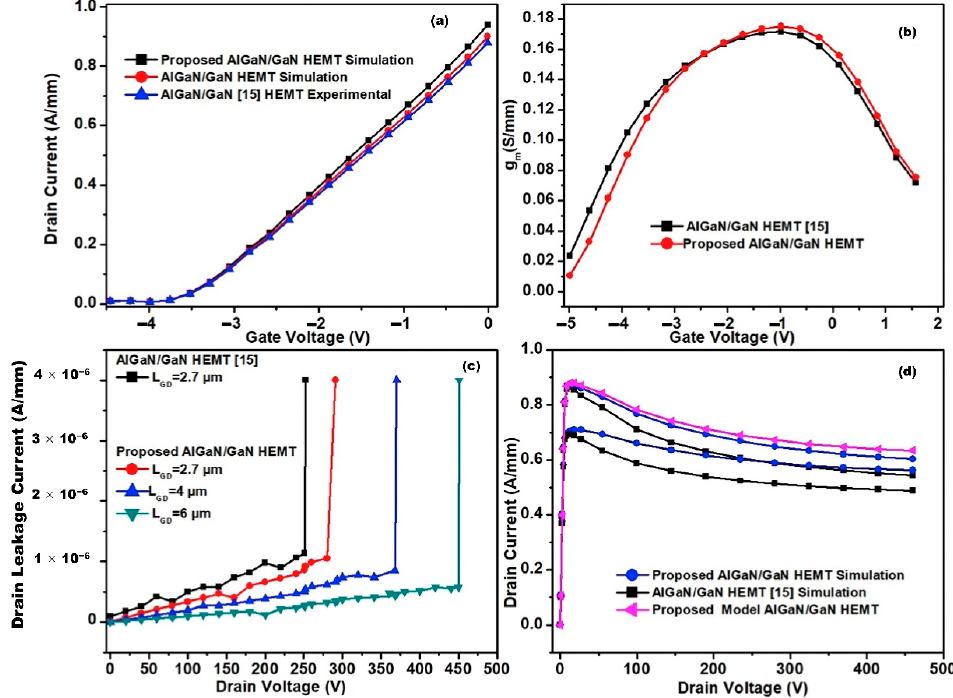
Figure 13. ( a ) Transfer characteristics, ( b ) g m of AlGaN/GaN HEMT, ( c ) drain leakage current (I ds ) versus V ds at V gs = − 10 V, and ( d ) I ds –V ds characteristics at V gs = − 1 V, 0 V. Reproduced with permission from ref. [184]. Copyright 2018 Elsevier.